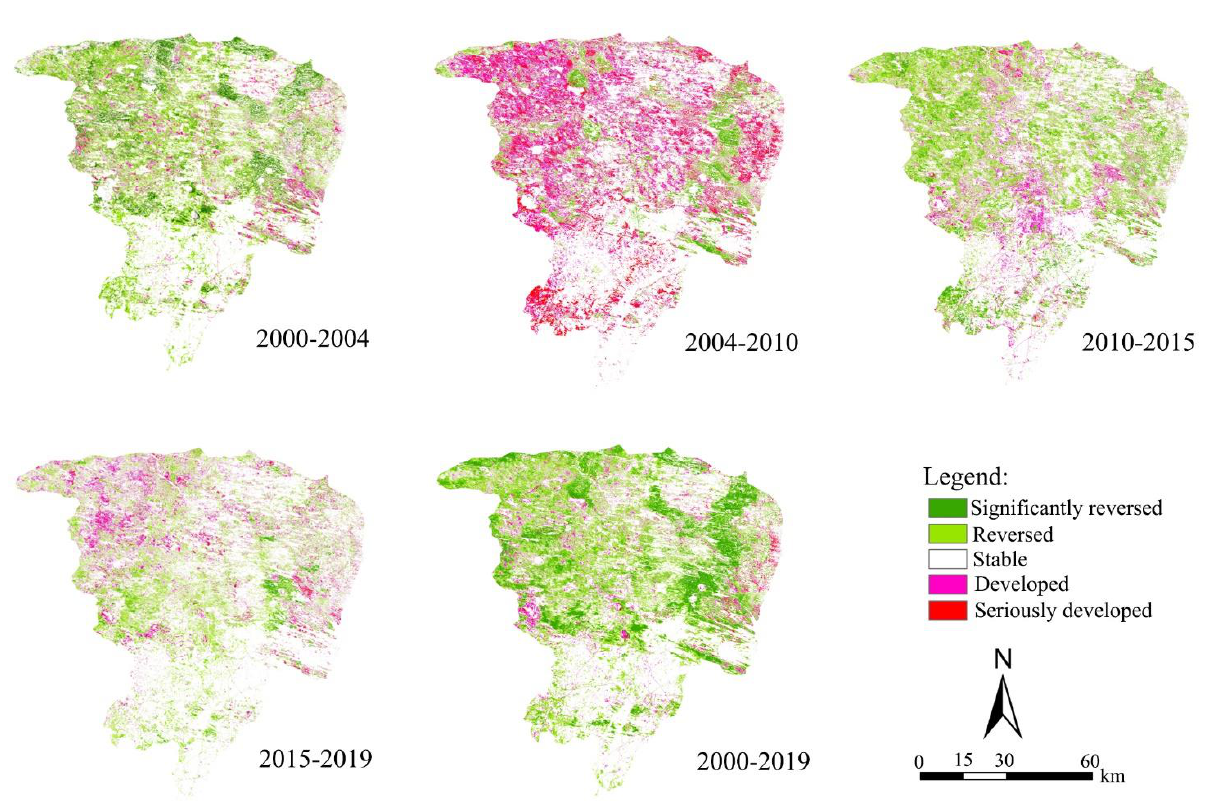
Figure 13. Aeolian desertification spatial distribution dynamic-change maps.